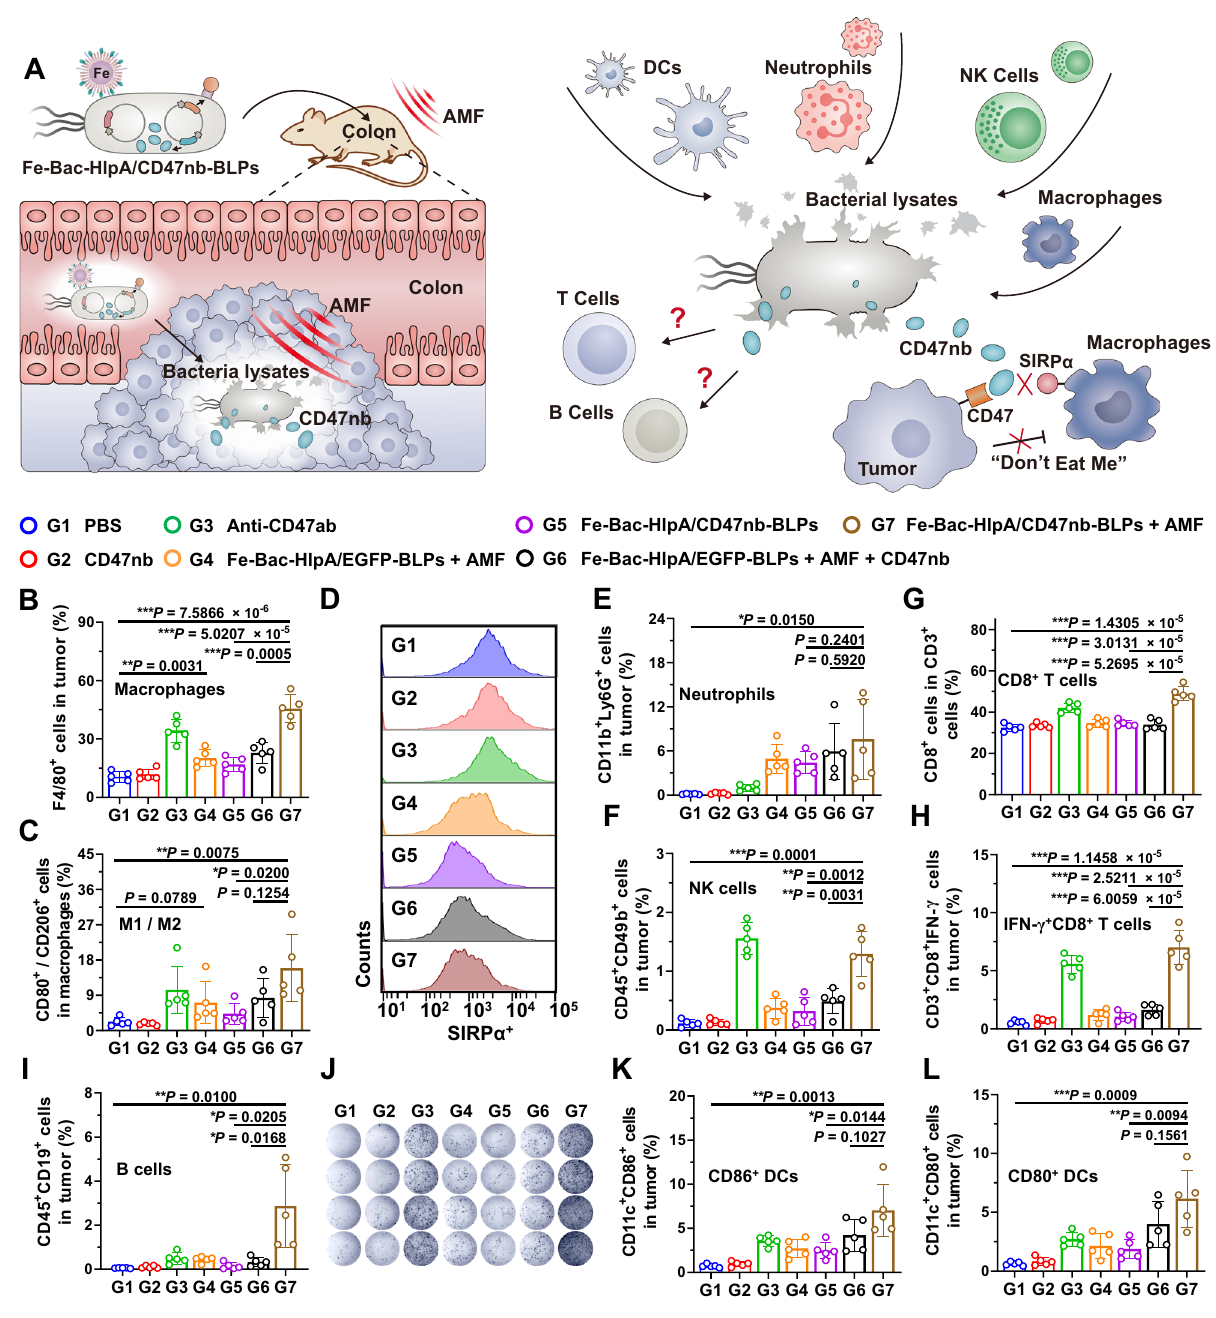
Fig. 6 | Immune responses induced by AMF-Bac. A Illustration of potential immune responses induced by AMF-Bac. AMF induces the lysis of bacteria, and bacterial lysates may recruit and/or activate macrophages, neutrophils, NK cells, and/or DCs. The release of CD47nb blocks the “ Don ’ t eat me ” pathway and enhancesthephagocytosisoftumorcellsbymacrophages.Besidesinnateimmune responses, the adaptive immune responses may also be affected. The colons of BALB/c mice were inoculated with CT-26 cells (1×10 5 cells/mouse) on day -7, and mice were treated with the indicated engineered bacteria (1×10 8 CFU) by colon- speci fi c administration on days 0 and 3, followed by AMF treatment (310kHz and 23.8kA/m) for 80min at24h after colon administration. The Anti-CD47ab (20mg/ kg) and CD47nb (20mg/kg) were i.p . injected on days 0 and 3 in G3 and G2/G6, respectively. Analysis of the immune responses was performed on day 9. B Flow cytometryanalysisofthepercentageofmacrophages(F4/80 + cells)intumors( n =5